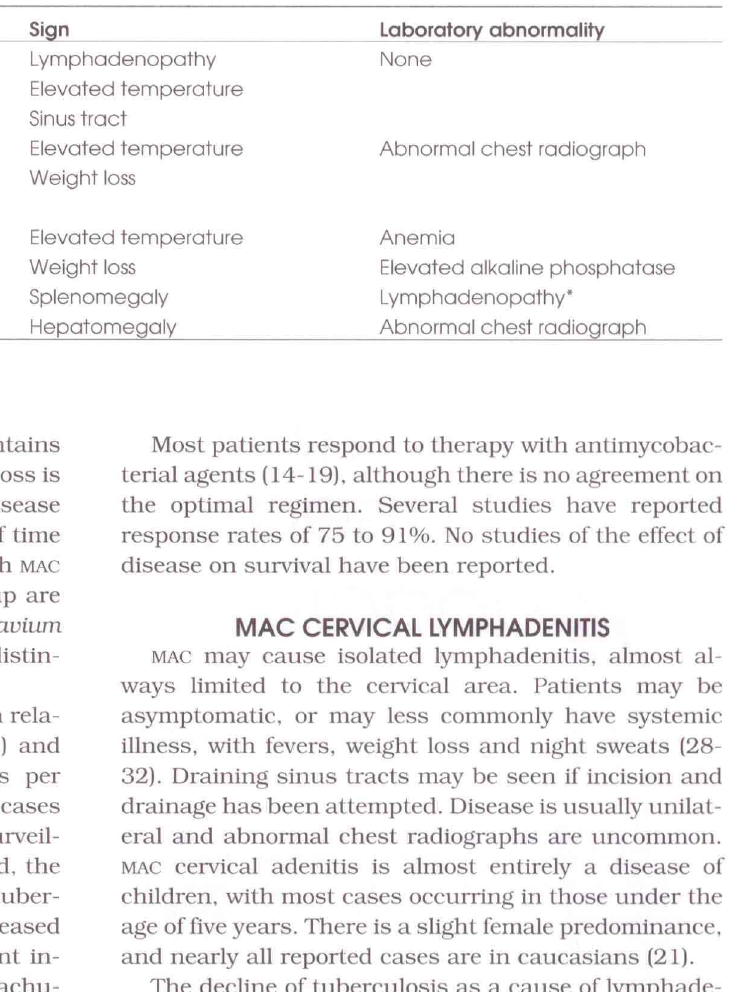
Symptoms, signs and laboratory abnormalities that may be observed in disease caused by Mycobacterium avium